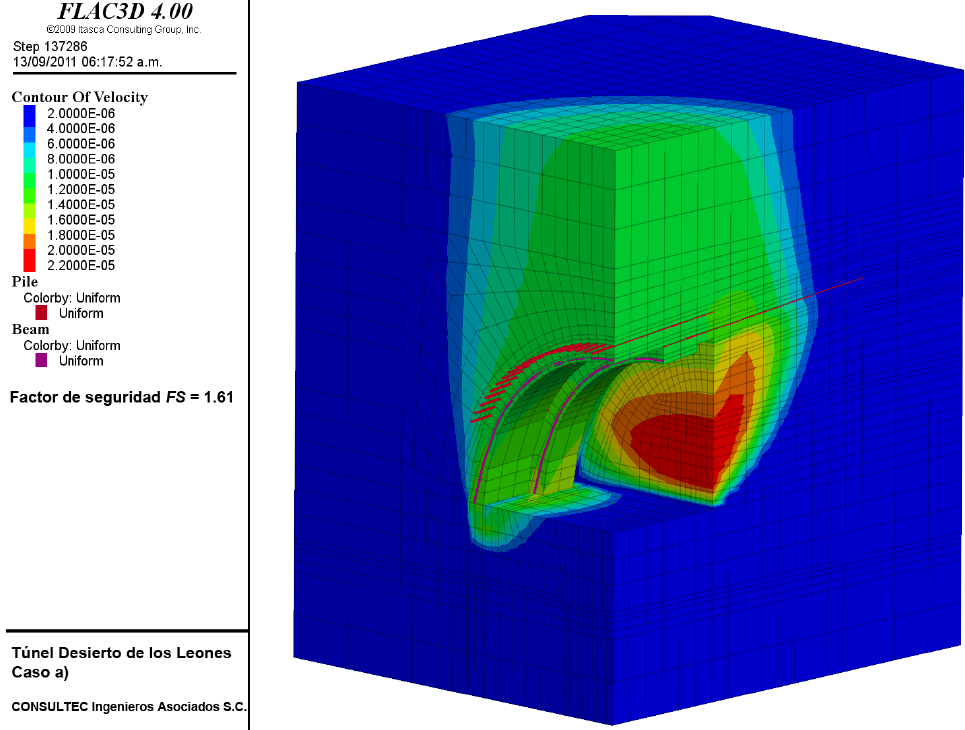
Figure 36. Potential mechanism of instability for case (a): shallow excavation in fill area with minimal parameters. Definition: Caso (a) (case a), Factor de seguridad (safety factor).